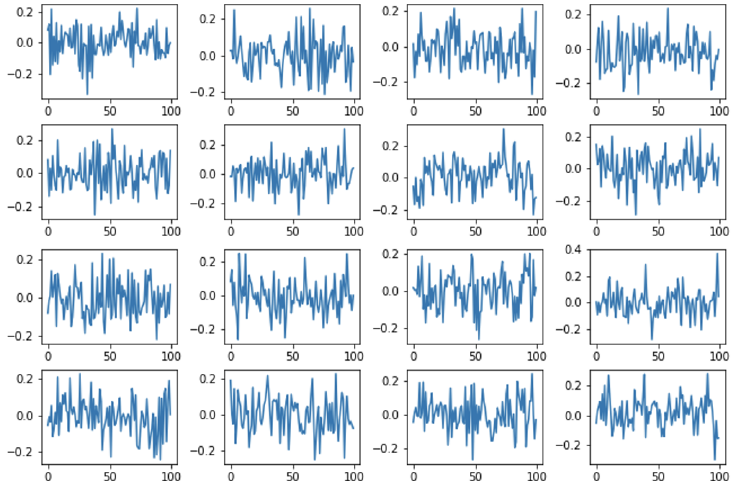
Figure 10. Examples atoms of the KSVD dictionary.